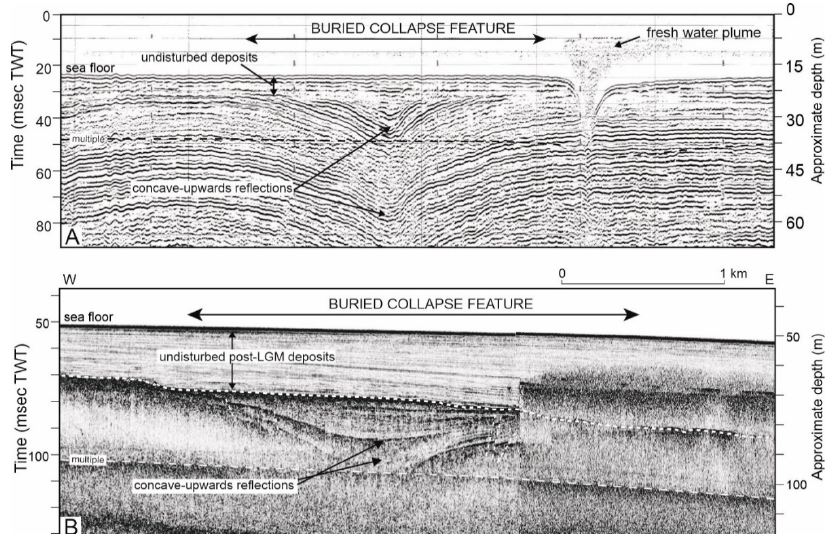
Figure 4. Examples of buried collapse structures. ( A ) High-resolution seismic profile of Crescent Beach Spring (Florida) and surrounding area. Resolution is not indicated in the cited work but it is likely to be in the order of 1 m considering a 500–2000 Hz source. The spring discharge is visible in the seismic image and the associated collapse feature (modified from Reference [77]). The horizontal scale is missing in the original figure, however, as a reference, the active spring vent related depression is ca. 150 m wide at the sea floor. ( B ) In the Gulf of Lions, buried collapse feature on a CHIRP profile (vertical resolution 2 to 5.2 kHz, i.e., 30–50 cm), interpreted as solution-subsidence ⁄ collapse associated with deep paleo-karst conduits [76]. LGM = last glacial maximum.